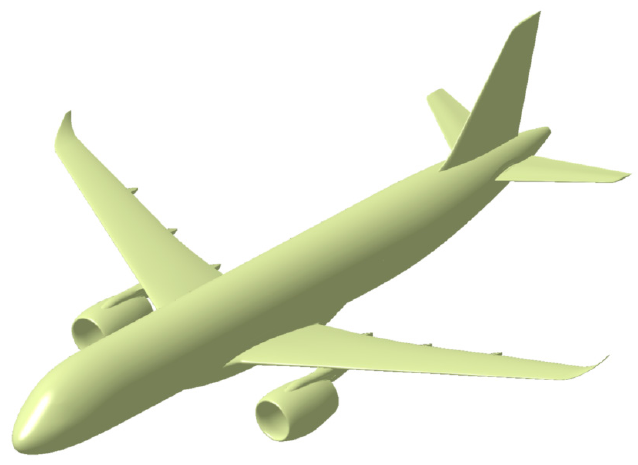
Figure 1. A passenger aircraft model with a low horizontal tail and wing crane engine configuration. Table 1. Main parameters of the simulation model. Wing Span, m Fuselage Length, m Simulation model ≈ 35 ≈